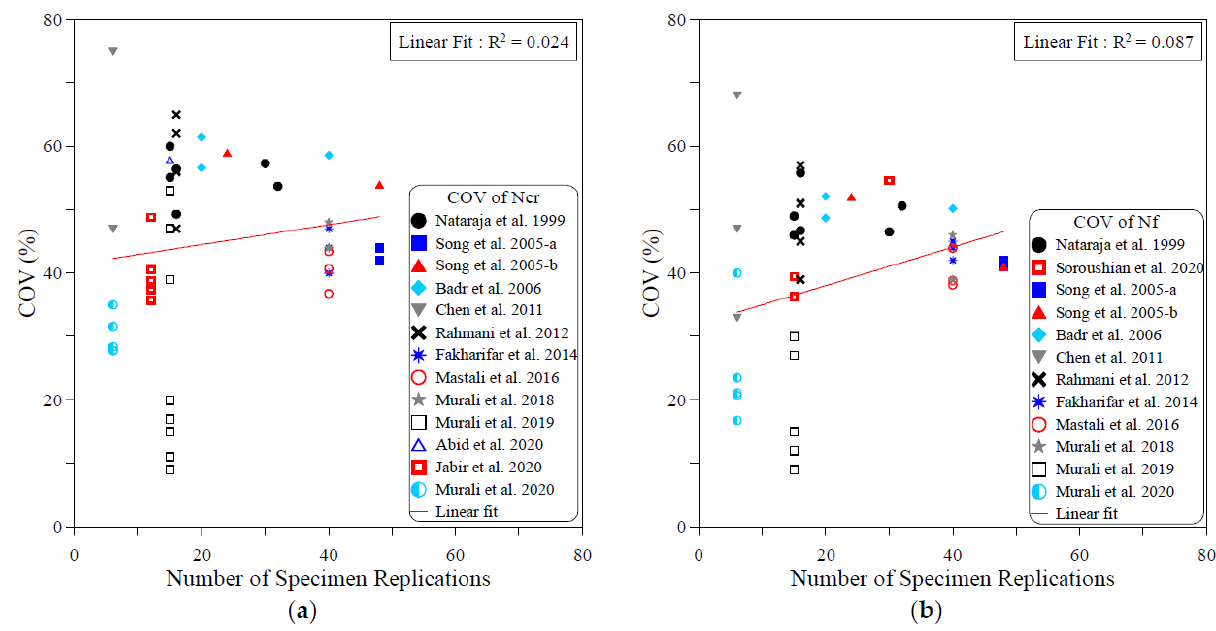
Figure 8. Effect of number of specimen replications on the scattering of impact results at ( a ) cracking and ( b ) failure.